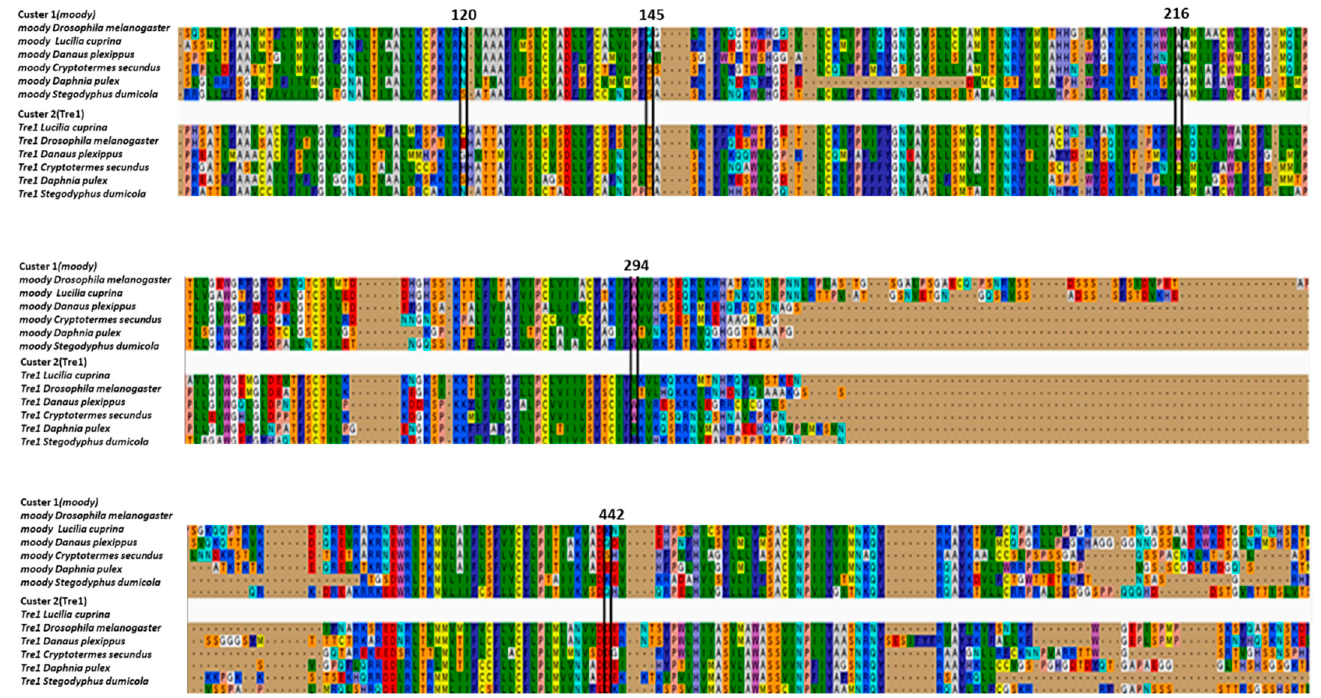
Figure 4. Functional divergence of the Tre1 family. Putative sites that caused a change of function between Tre 1 family and Moody family.